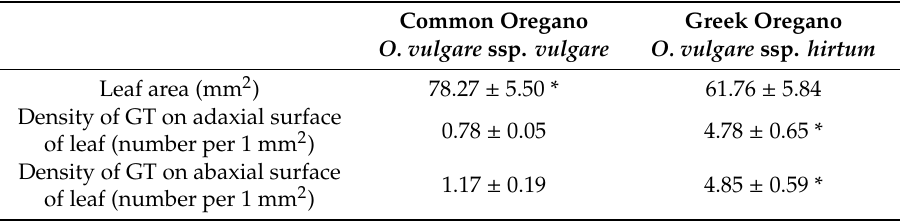
Table 4. Leaves area and density of glandular trichomes (GT) on the